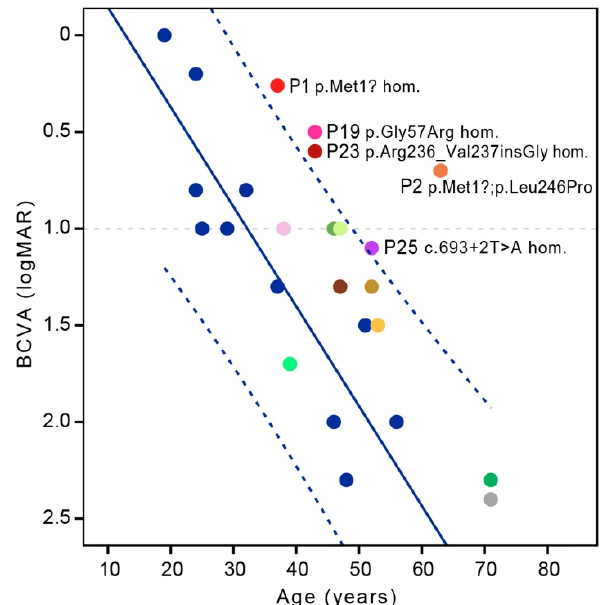
Figure 8. Visual acuity at last exam in patients harboring variant p.Gly47Valfs*3 (blue color) and other biallelic variants (other colors, all homozygotes are in the shades of blue) in DRAM2 . Five patients had visual acuity above the 95% CI of the baseline group: Patient 1 (p.Met1? homozygous), Patient 2 (p.Met1?; p.Leu246Pro), Patient 19 (p.Gly57Arg homozygous), Patient 23 (p.Arg236_Val237insGly homozygous) and Patient 25 (c.693 + 2T > A homozygous). Note that all patients with pathogenic variant p.Gly47Valfs*3 are in the blue color. Note that the colors of the patients are the same in Figures 5–8.